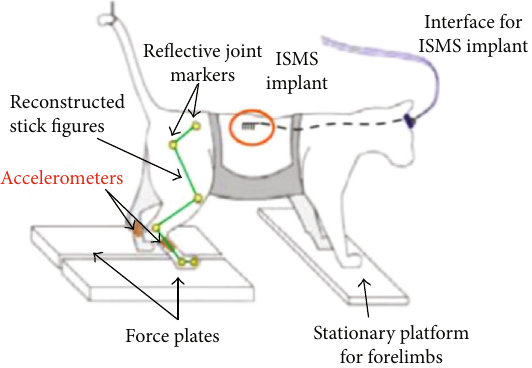
Figure 5: Bilateral walking experiment of activation by